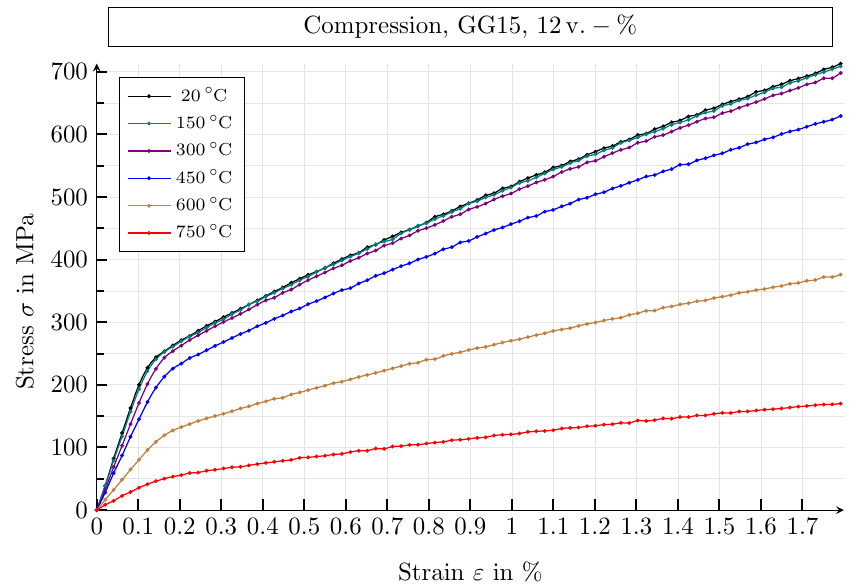
Figure 18. Stress–strain diagrams of a GJL-150 graphite morphology under tensile load, with 12v. of graphite precipitations and variable temperature.